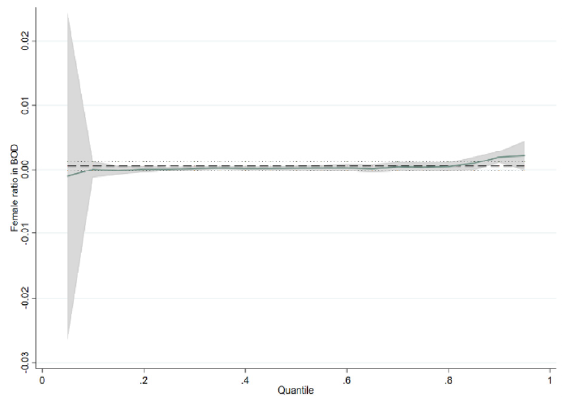
Figure 6. The quartile impact of female ratio on ROA.